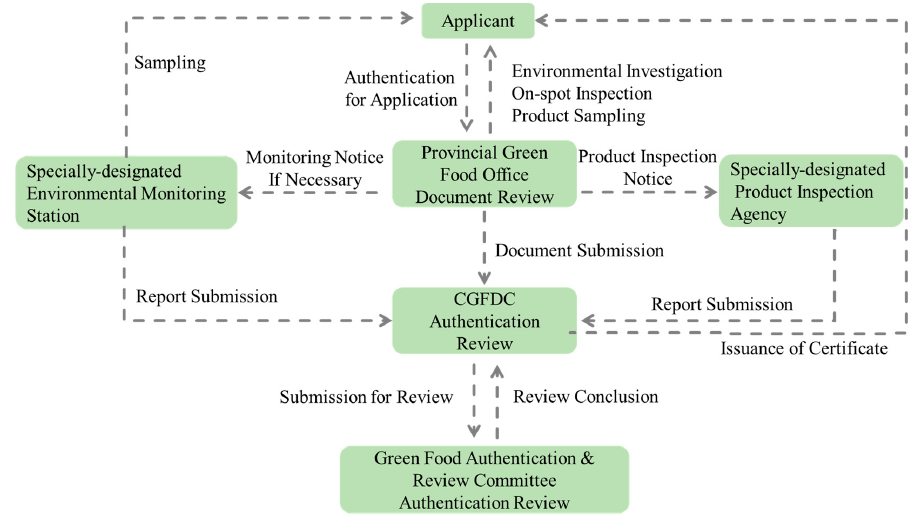
Figure 3. Schematic illustration of green food authorization in China. CGFDC, China Green Food Development Center.